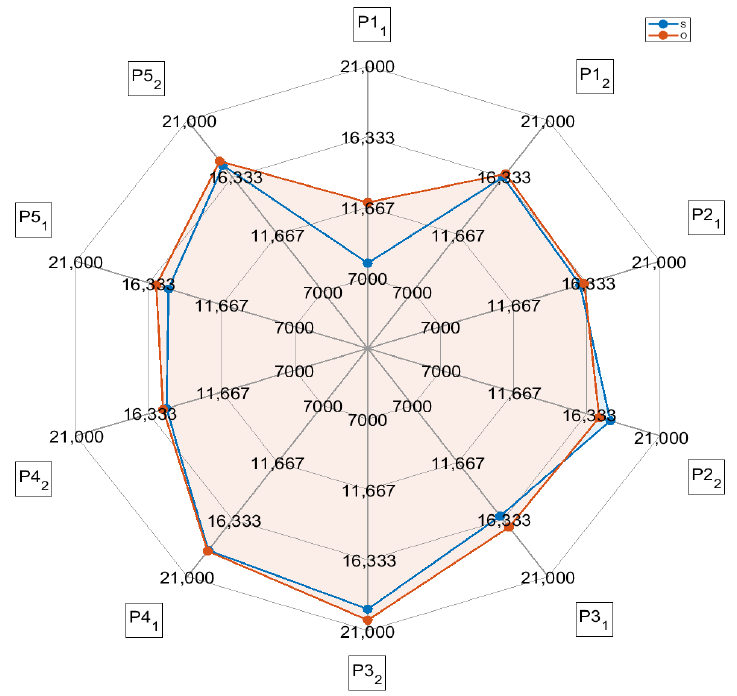
Figure 10. The average signal values of each sensor for the gestures corresponding to letters “O” and “S”.